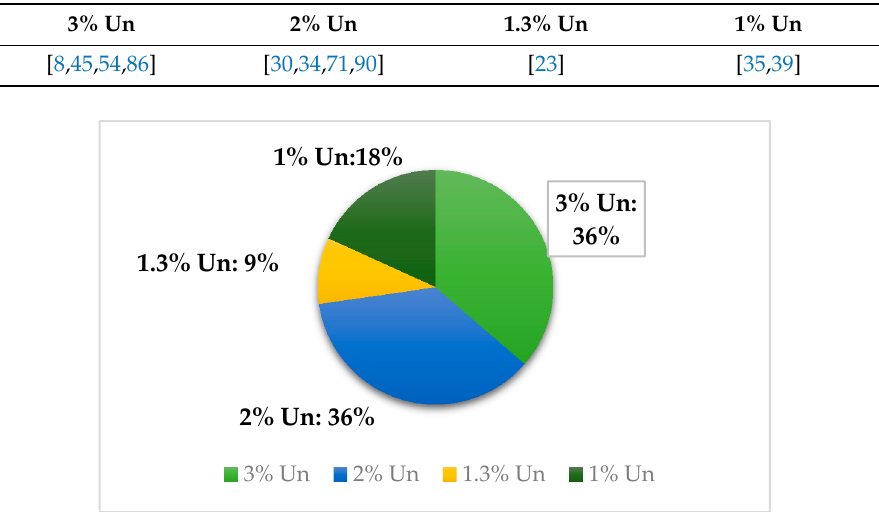
Table 4. Voltage Unbalance limits applied in different studies.